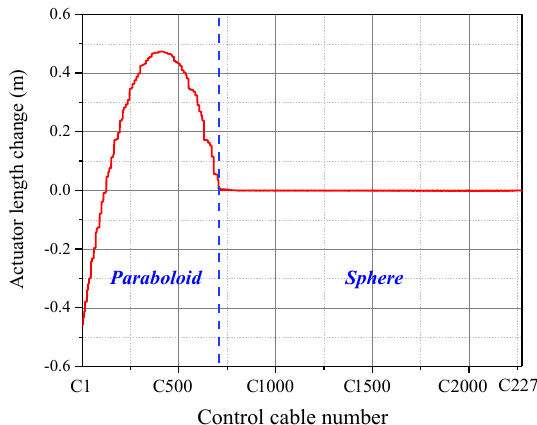
Figure 16. Stress distribution of cables: ( a ) stress distribution of main cables; ( b ) stress distribution of control cables.